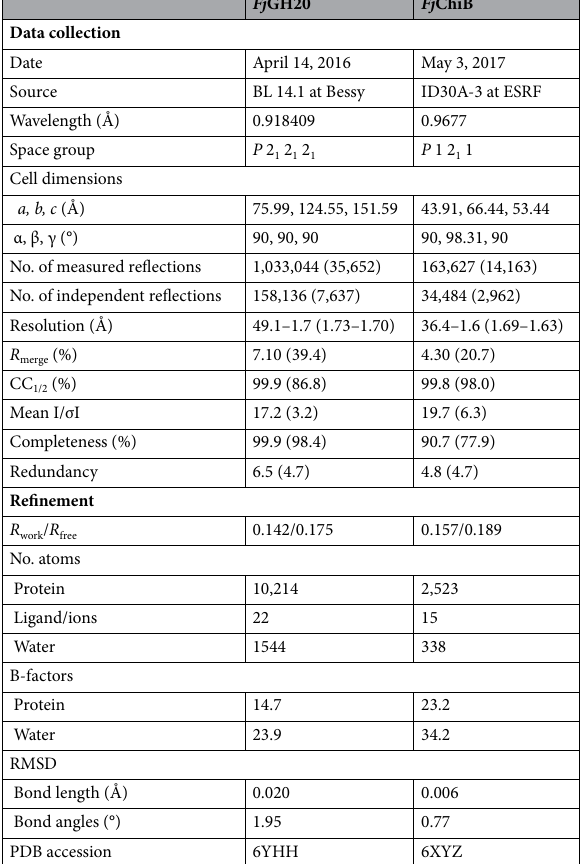
Table 2. Structure determination of Fj chiB. Fj ChiB was produced and purified as previously reported 8 and